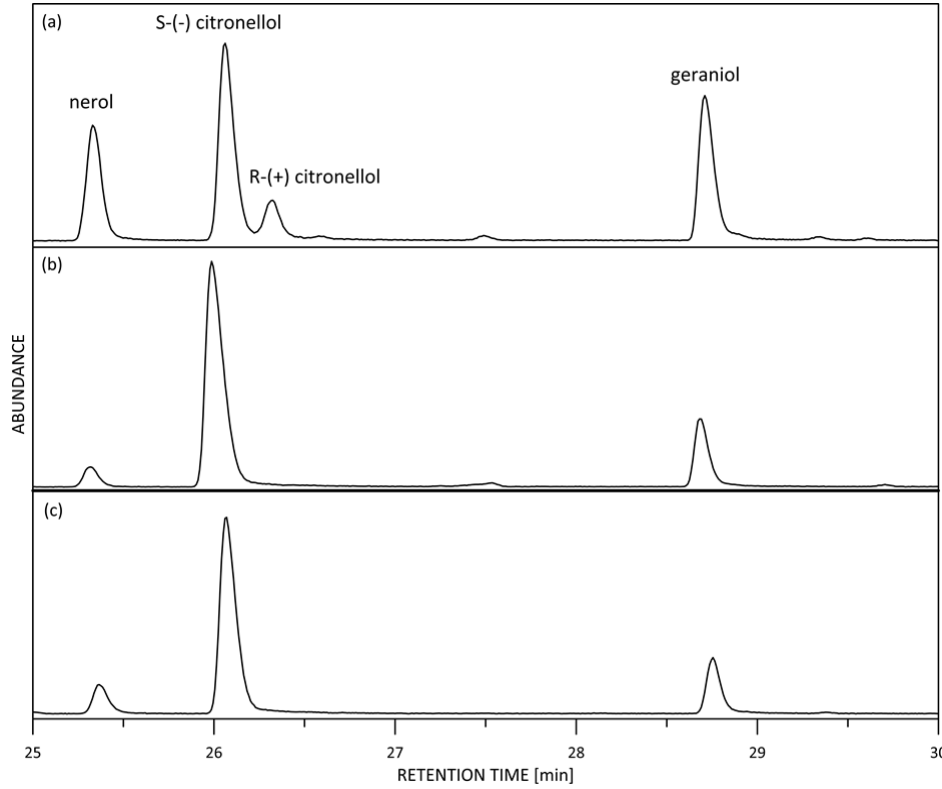
Figure 4. GC/MS (TIC) chromatograms on a chiral stationary phase Cyclodex-B: ( a ) R. rugosa ; ( b ) Kushui rose; ( c ) R. damascena. ( b ) Kushui rose; ( c ) R. damascena